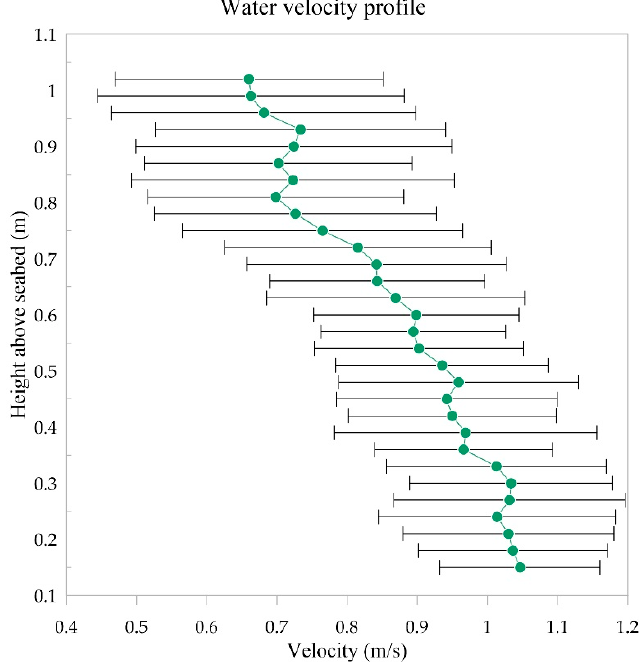
Figure 8. Vertical profile of horizontal velocities during large wave trains in the 15 min interval. Error bands depict the standard deviation.